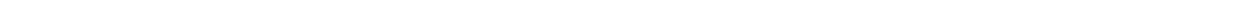
Fig. 4 DEP1 and OsMADS1 cooperatively regulate a common set of target genes. a The number and overlap of DEP1 and OsMADS1 targets. RNA-seq experiments were performed based on template extracted from young NIL panicles. b Transcript abundances of the common target genes examined in the indicated NILs plants. The relative abundances in NIL- LGY3-DEP1 plants was set to be one. Data shown as mean ± s.e.m. ( n = 6). c ChIP assays of the WYJ7- LGY3-DEP1 and WYJ7- lgy3-DEP1 plants. The DNA fragments either containing or non-containing CArG-box motifs (arrowed) in the promoter regions of the targets OsMADS55 , OsKANADI42 , OsPIN1a , and OsARF9 were used. Data shown as mean ± s.e.m. ( n = 6). A Student ’ s t -test was used to generate the P values. d EMSA assays. Competition for either OsMADS1-GST or OsMADS1 lgy3 -GST binding was performed with 10× and 50× unlabeled probes containing the CArG-box motifs, respectively. e ChIP analysis of the OsMADS1 interaction with the promoter regions of OsMADS55 , OsKANADI2 , OsPIN1a , OsARF9 , or OsARF14 with amplicon sequences shown in Fig. 3c. Data shown as mean ± s.e.m. ( n = 3). Statistical analyses were performed by Duncan ’ s multiple range tests. f The effect of deleting the K domain on the DEP1-dependent promotion of OsMADS1-induced transactivation activity of the OsARF9 promoter. The ratio of LUC to REN activity was monitored in rice protoplasts co-transfected with various effector and reporter constructs. The LUC/REN activity obtained from a co-transfection with an empty effector construct and reporter construct was set to be one. Data shown as mean ± s.e.m. ( n = 6). g The DEP1-OsMADS1 interaction promotes the OsMADS1 -induced target gene transactivation activity. The LUC/REN activity obtained from a co- transfection with an empty effector construct and indicated reporter constructs was set to be one. Data shown as mean ± s.e.m. ( n = 6). Statistical analyses were performed by Duncan ’ s multiple range tests. The presence of the same lowercase letter denotes a non-signi fi cant difference between means ( P >